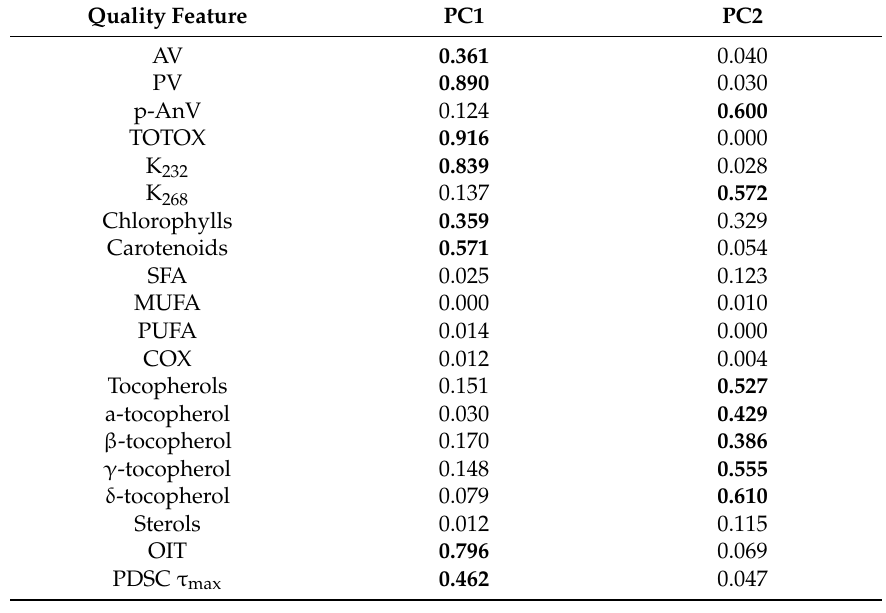
Table 5. Principal component analysis (PCA) factor loadings for the quality factors of analyzed oils.